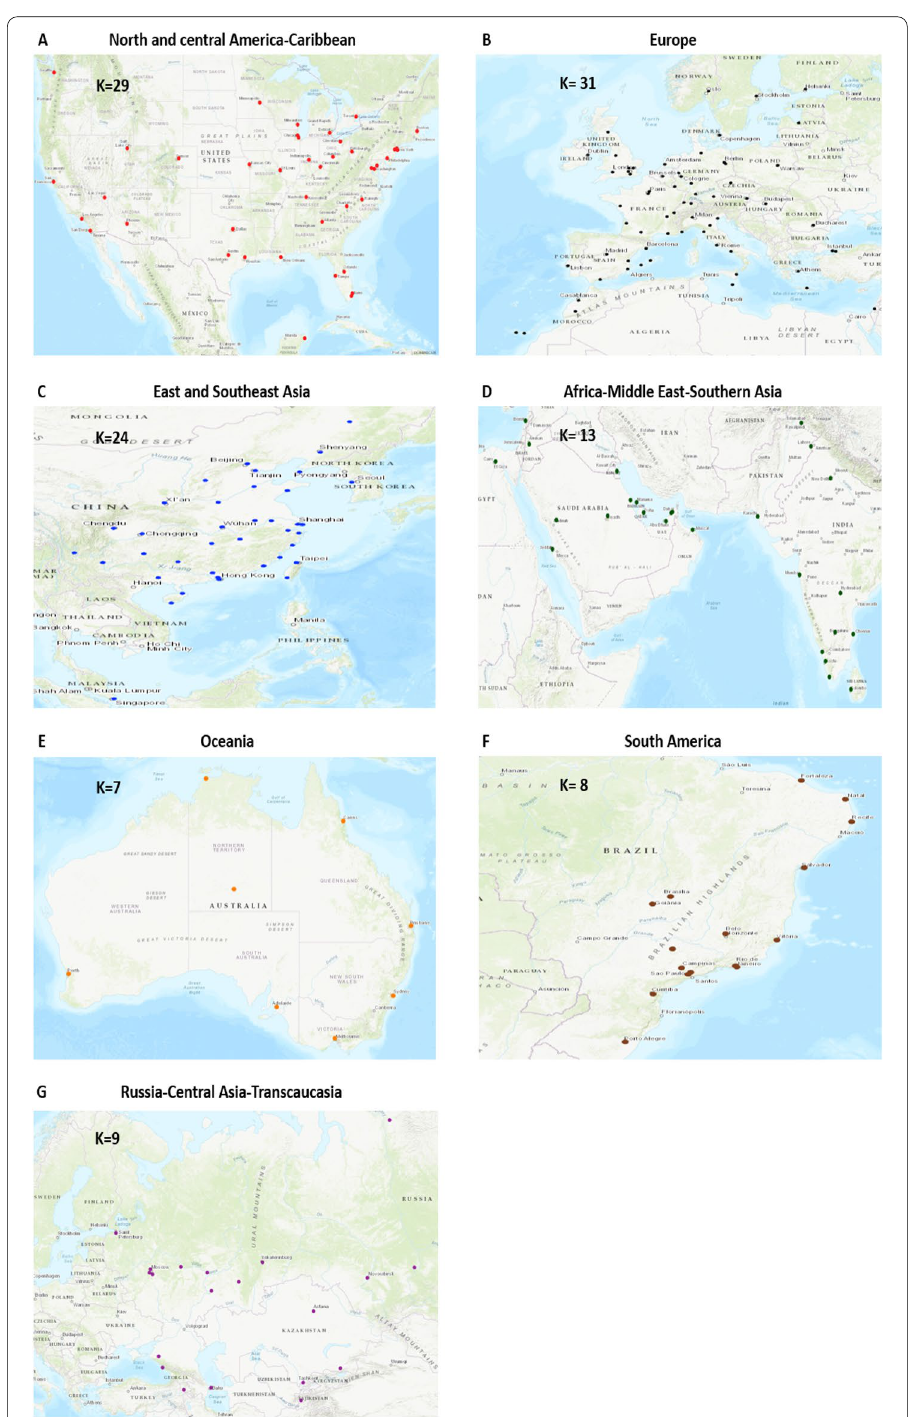
Fig. 15 Core of the large local components. The dots represent the airports, and K is the maximum k-core. The core of the North and Central America-Caribbean component contains 42 airports. The core of Europe contains 65 airports. The core of East and Southeast Asia contains 38 airports. The core of Africa-Middle East-Southern Asia contains 26 airports. The core of Oceania contains 8 airports. The core of South America contains 16 airports. The core of Russia-Central Asia-Transcaucasia includes 19